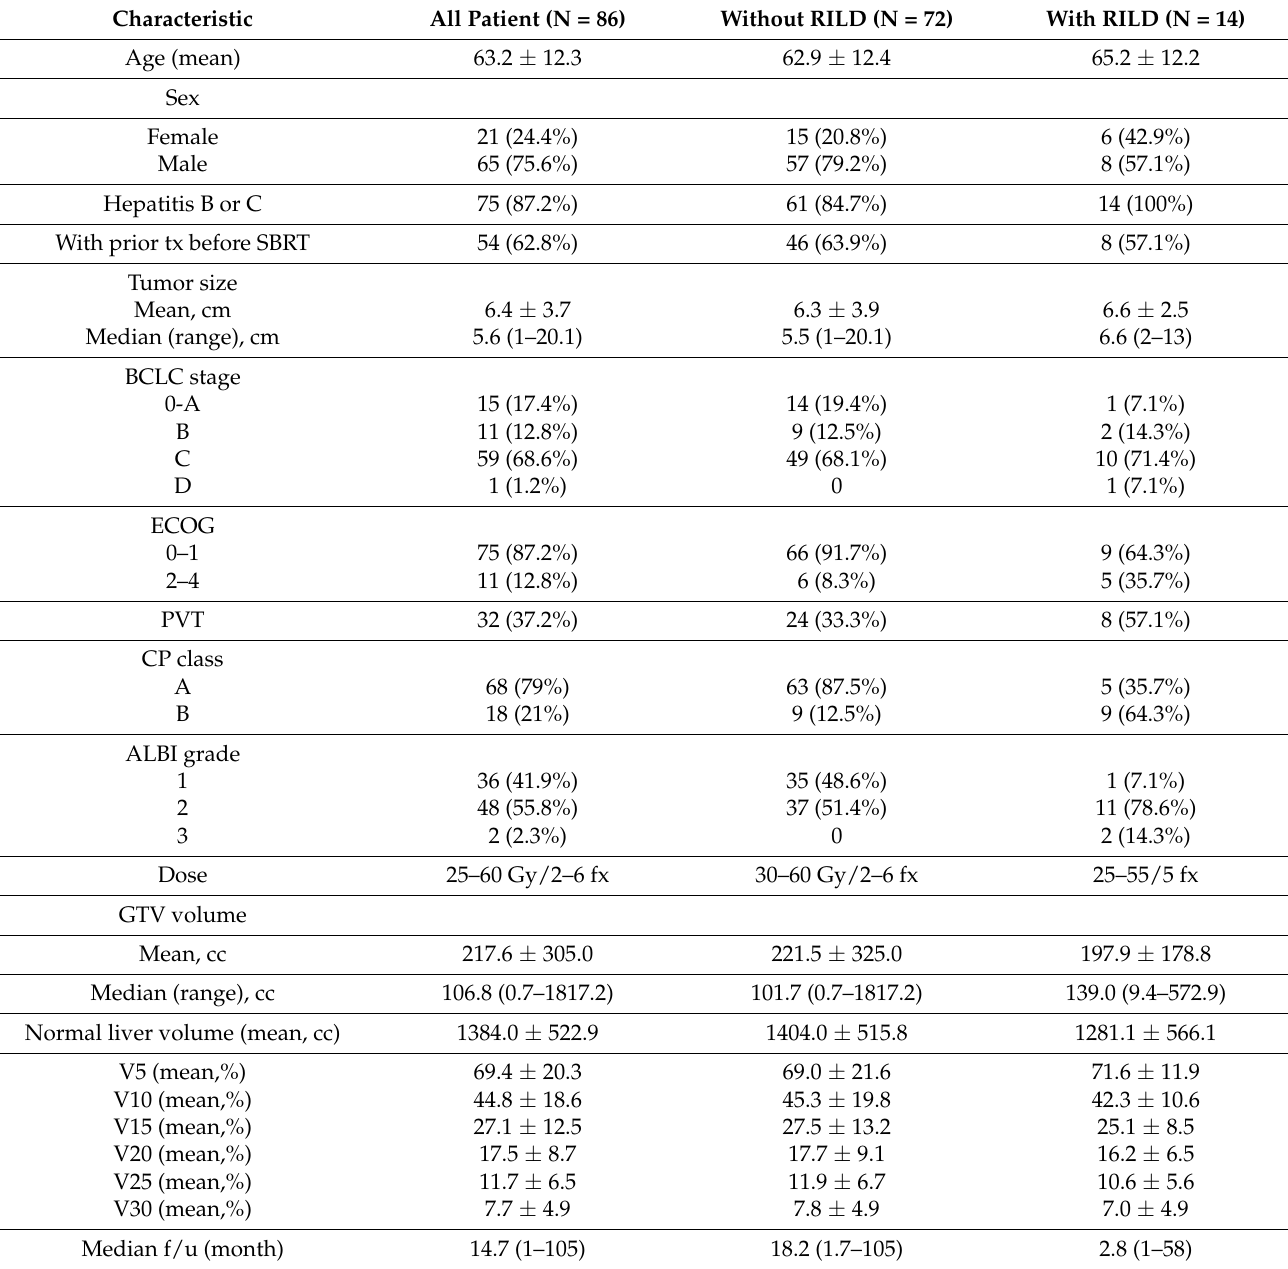
Table 1. Patient, tumor, and treatment characteristics for overall, RILD and non-RILD